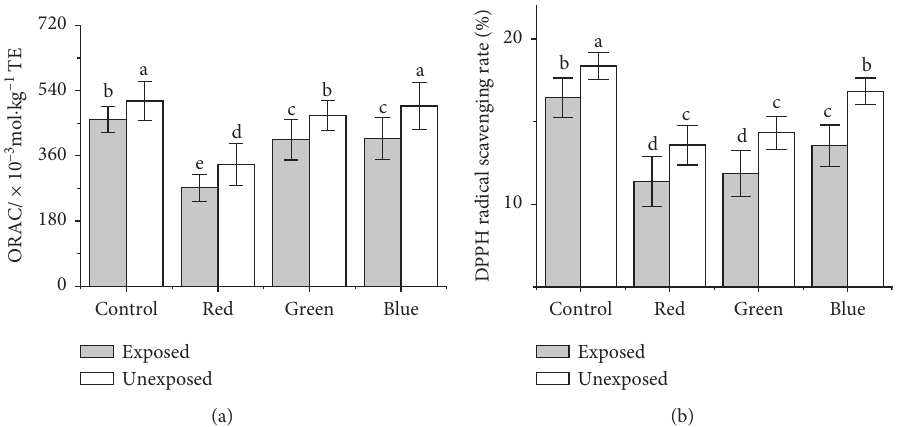
Figure 5: Effect of light exposures on ORAC value (a) and DPPH radical scavenging capacity (b) of fresh-cut watermelon. Data are mean ± standard deviation ( n ≥ 3). Means with different letter represent a significant difference ( P < 0 . 05).